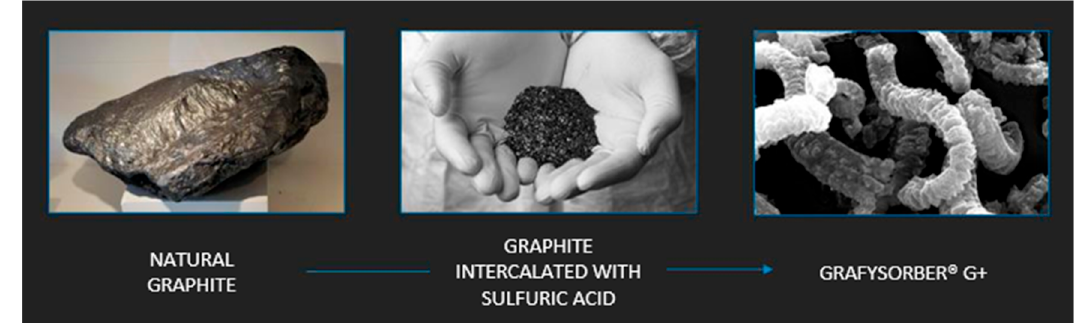
Figure 1. Production process of Grafysorber ® G+.